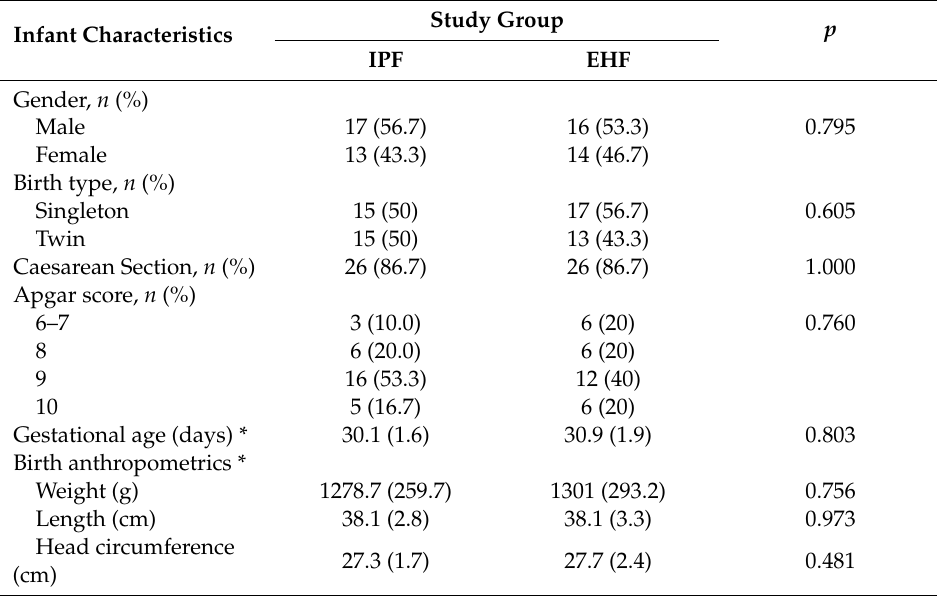
Table 2. Infant characteristics at study